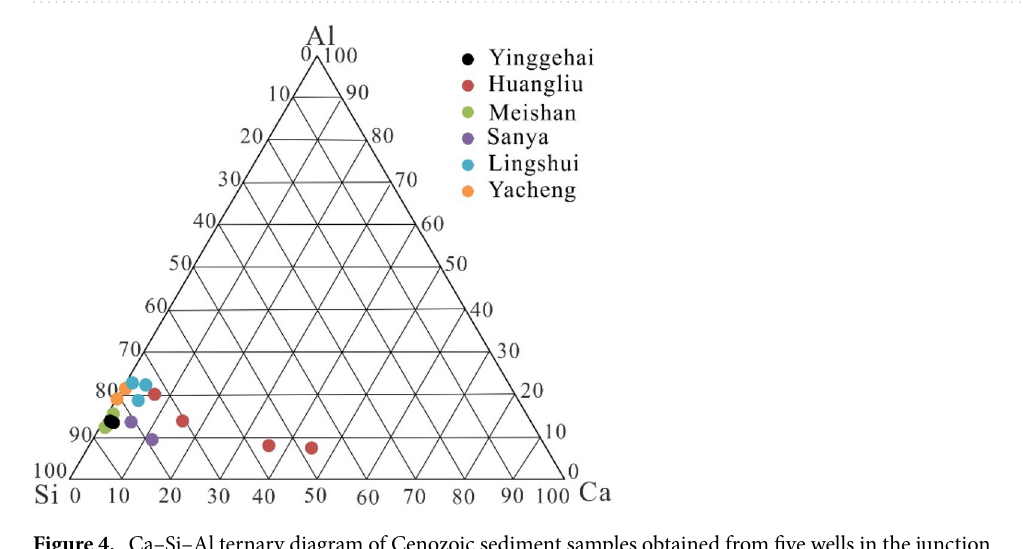
Figure 4. Ca–Si–Al ternary diagram of Cenozoic sediment samples obtained from five wells in the junction area of Yinggehai and Qiongdongnan